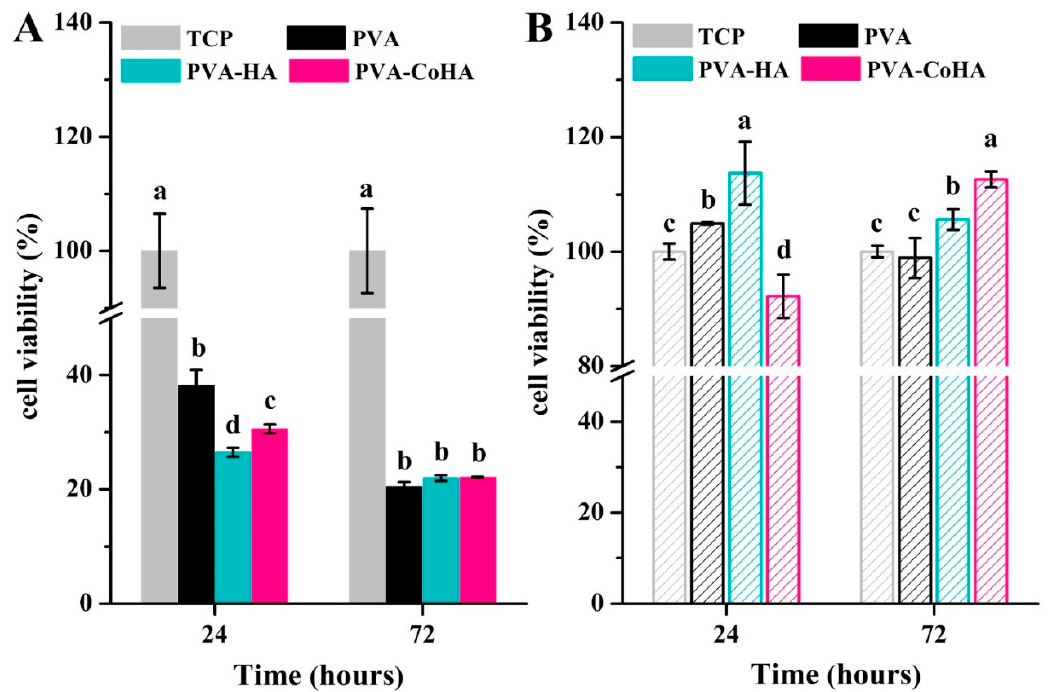
Figure 7. Biocompatibility of the PVA and PVA-CoHA nanocomposite. ( A ) Cells are grown on the surface. ( B ) The cells are cultured using extraction solutions. Means with different letters ( a – d ) were significantly different ( p < 0.01, mean ± SD, n = 4).